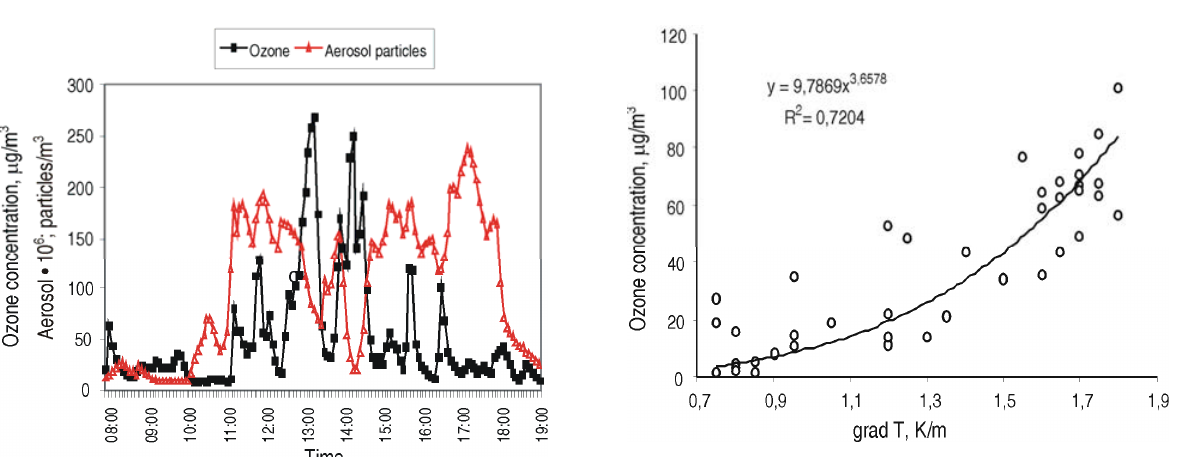
Fig. 5. Variation of ozone and aerosol numerical concent- rations (without additional room ventilation)